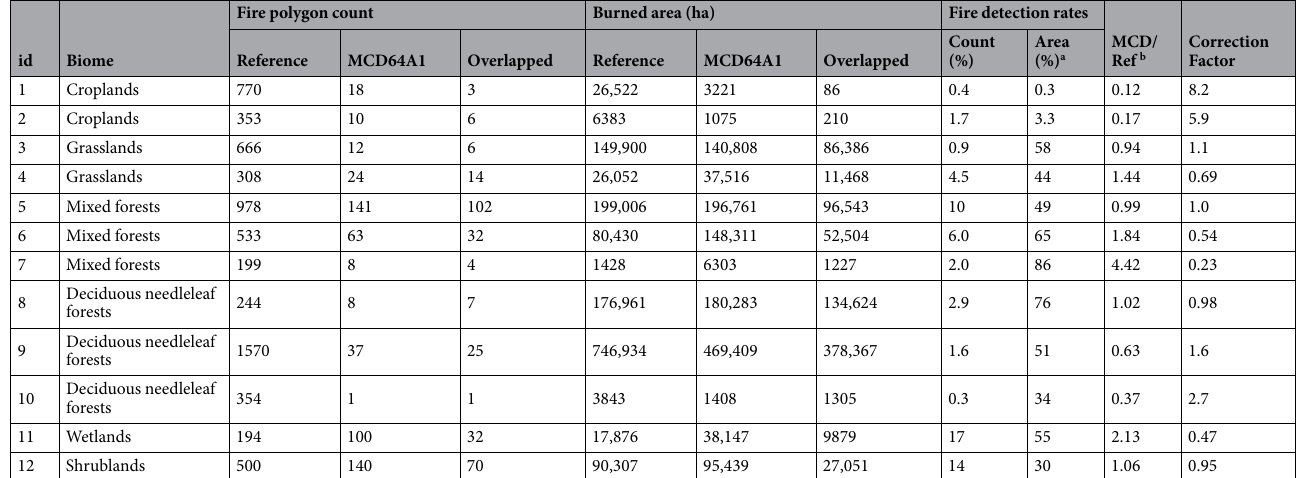
Table 1. General results of validation of MCD64A1 burned area products in boreal Eurasia. a Area (%) indicates the burned area detection rate (BADR) of MCD64A1. b MCD/Ref indicates the ratio between MCD64A1 and reference burned area.